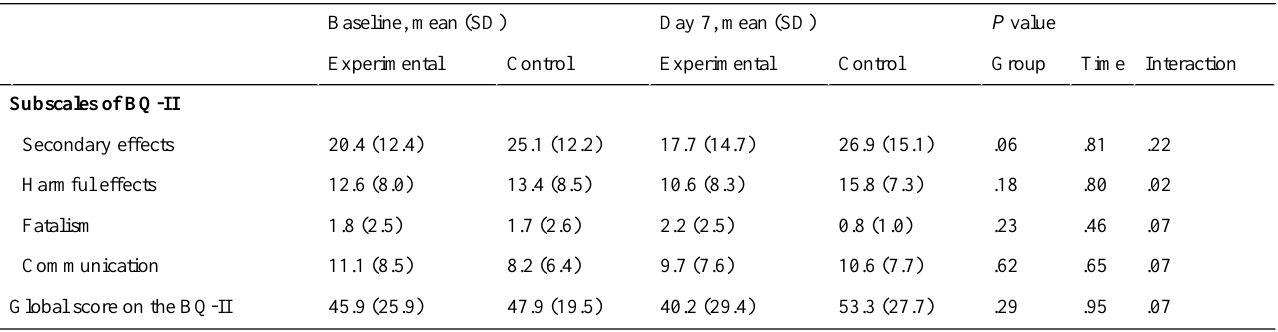
P valueDay 7, mean (SD)Baseline, mean (SD)